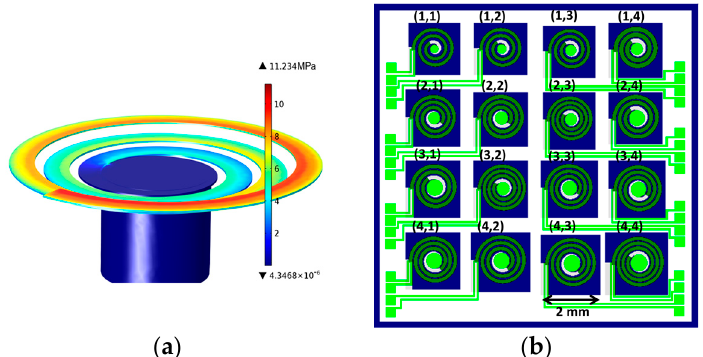
Figure 1. ( a ) Tensile stress distribution along the beam calculated by finite element analysis to exclude “fragile” geometries upon selection; ( b ) Layout of the selected 4 × 4 spirals. Each of the spirals fit into a square area of 2 mm × 2 mm. Five geometrical parameters of the Archimedean spirals were varied to tune the natural frequency: number of the half turns, width (W), starting radius at the clamping point ( R 0 ), radius of the proof mass cylinder ( r 0 ), and c parameter, describing the rate of the radius change from the edge towards the center.